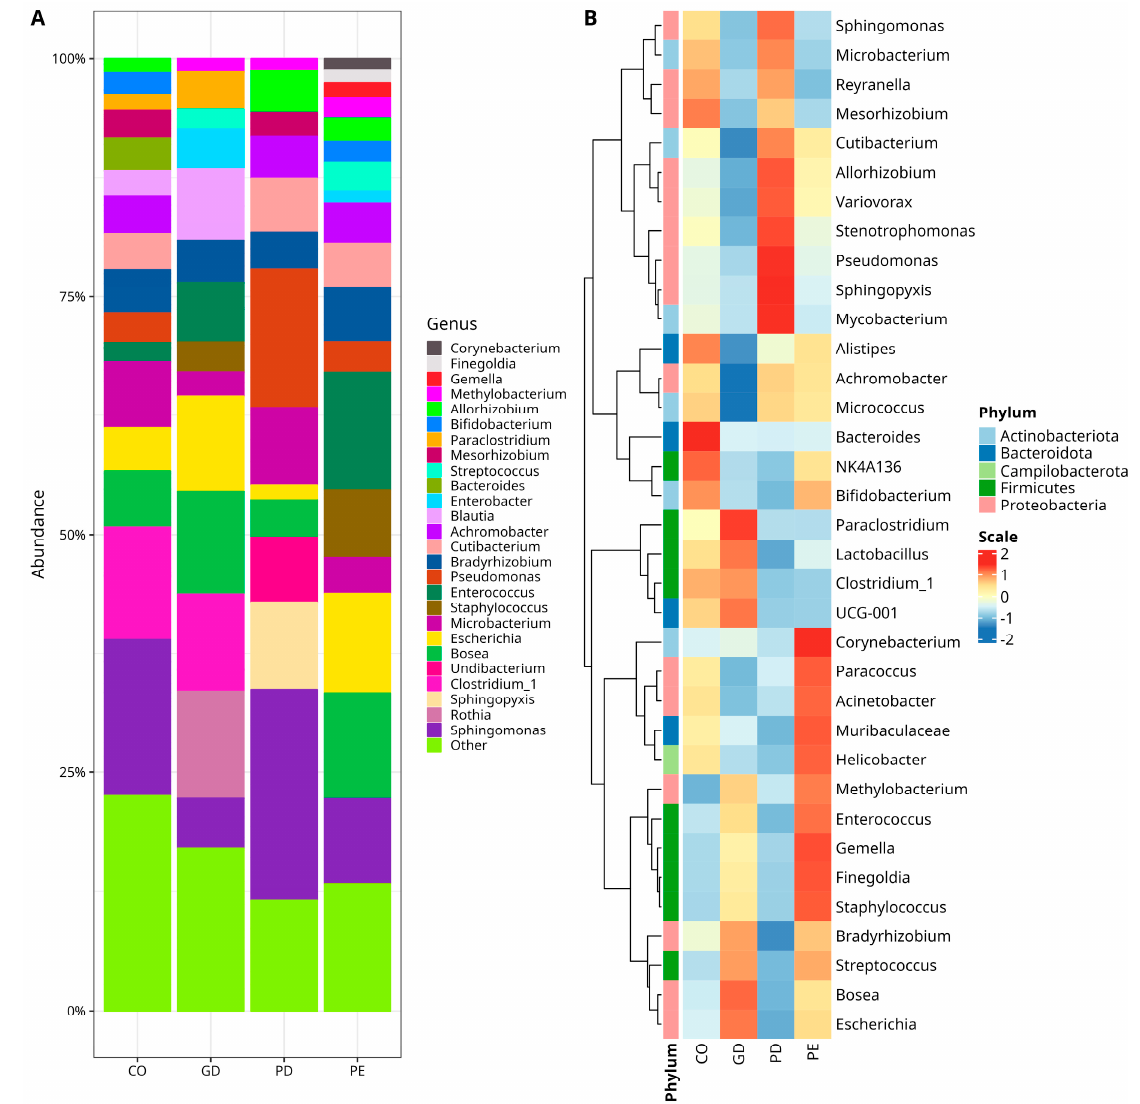
Figure 2. Relative abundances of bacterial genera in the studied samples. ( A ) Stacked bar plots with relative abundances of bacteria. Color sectors indicate taxa as indicated by tags at the right side of the figure; abundances are shown as percentages on the Y-axis. The graphic shows the twenty-six topmost abundant genera, while “Other” group genera with <1% relative abundance— (see Supplementary Materials for numerical data abundance and statistical test for CO versus GD, Table S6; CO versus PD, Table S7, and CO versus PE, Table S8). ( B ) Core microbiota heatmap among samples. Columns show the abundance of core microbiota members with a prevalence of at least 50% in the samples and an abundance ≥ 1%. The color scale from blue ( − 2) to red (2) indicates the relative abundance normalized from the core taxa of groups. Color keys for phyla are shown on the left side of the figure. NK4A136 (Lachnospiraceae), UCG-001 (Prevotellaceae), Methylobacterium ( Methylobacterium-Methylorubrum ), Clostridium_1 ( Clostridium_sensu_stricto_1 ). The type of sample is indicated at the bottom of the figure, where PE (Pre-Eclampsia), PD (Pre-gestational Diabetes), GD (Gestational Diabetes), and CO